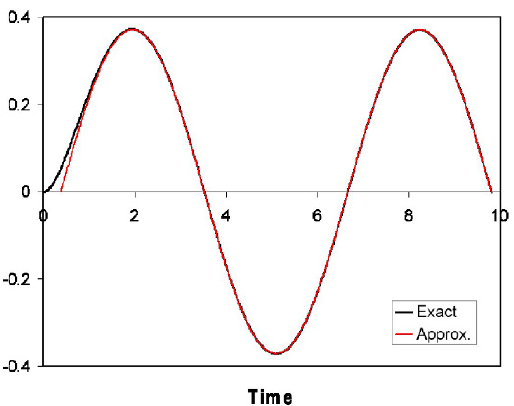
Figure 4. Comparison of exact versus approximate displacement response ( ¯ α versus τ ) to an exponential pulse with ωt d = 0 . 4 .